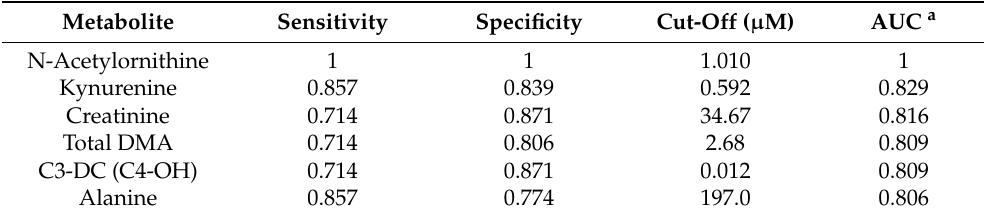
Table 1. Values of sensitivity, specificity, and area under the curve obtained from the ROC plots in Figure 1.